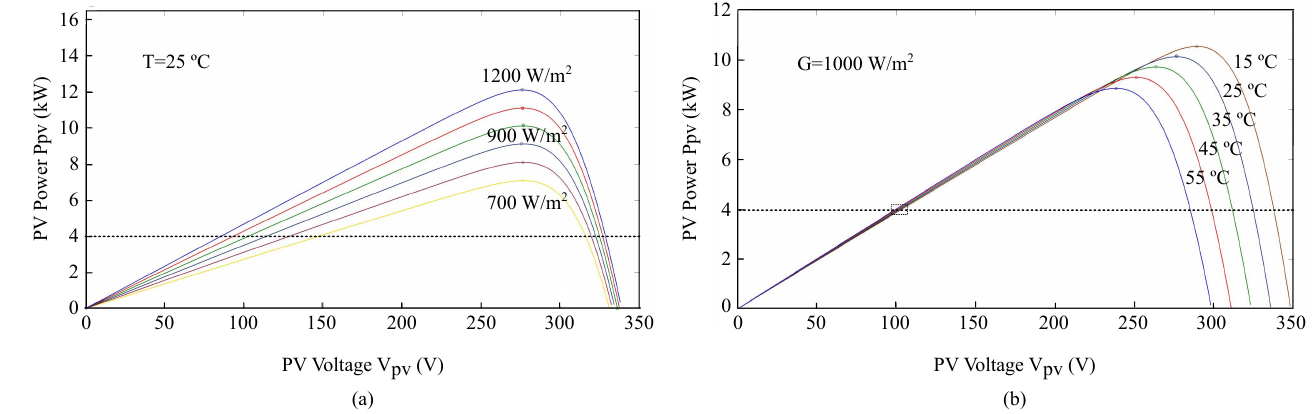
Figure 13. P-V characteristics of PV array with environmental changes: ( a ) P-V characteristics of PV array for variations of irradiance, and ( b ) P-V characteristics of PV array at variations of